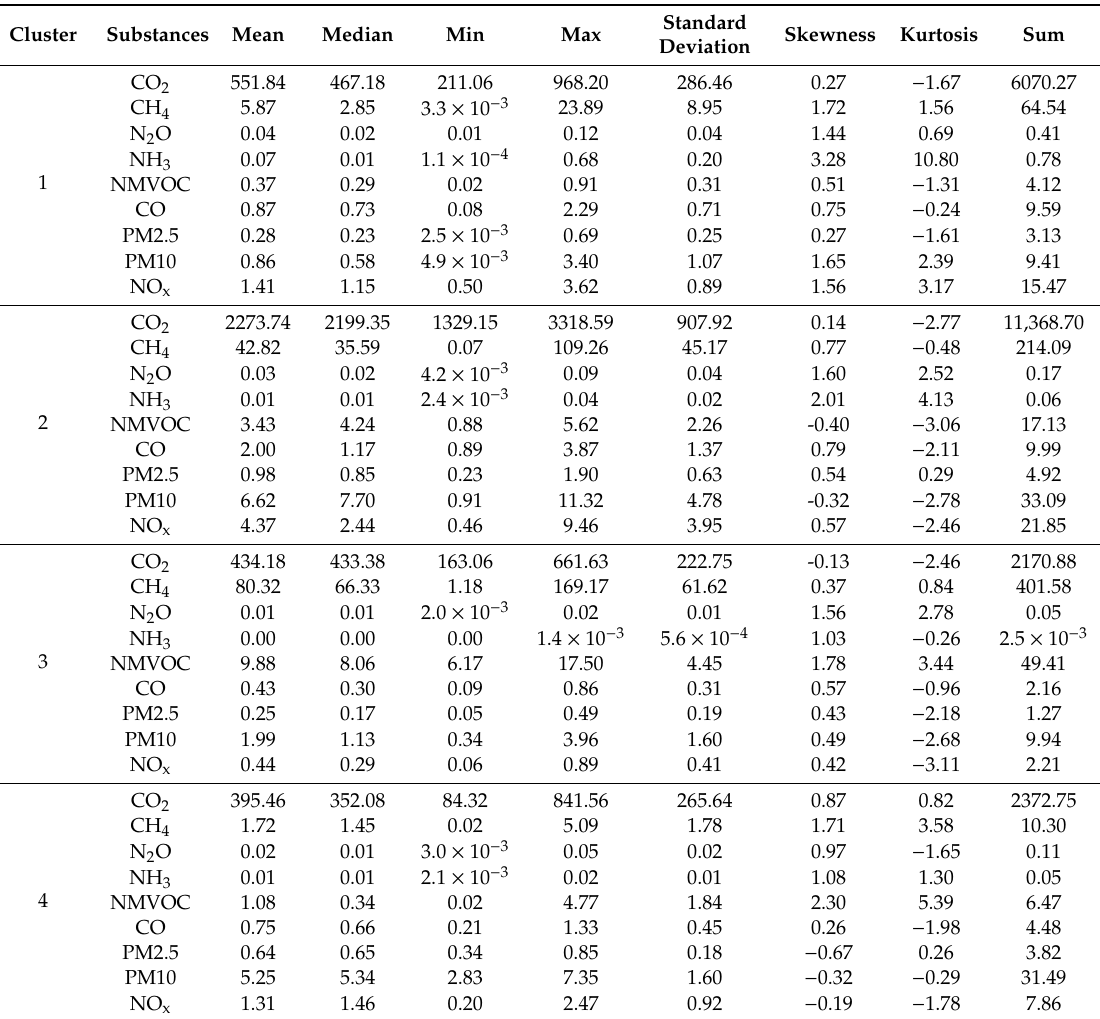
Figure 7. Topological map for individual similar groups of the EU countries (own elaboration). Table 10. Results of statistical analysis regarding the emission of harmful substances compared to the GVA for individual clusters of the EU countries (own elaboration).